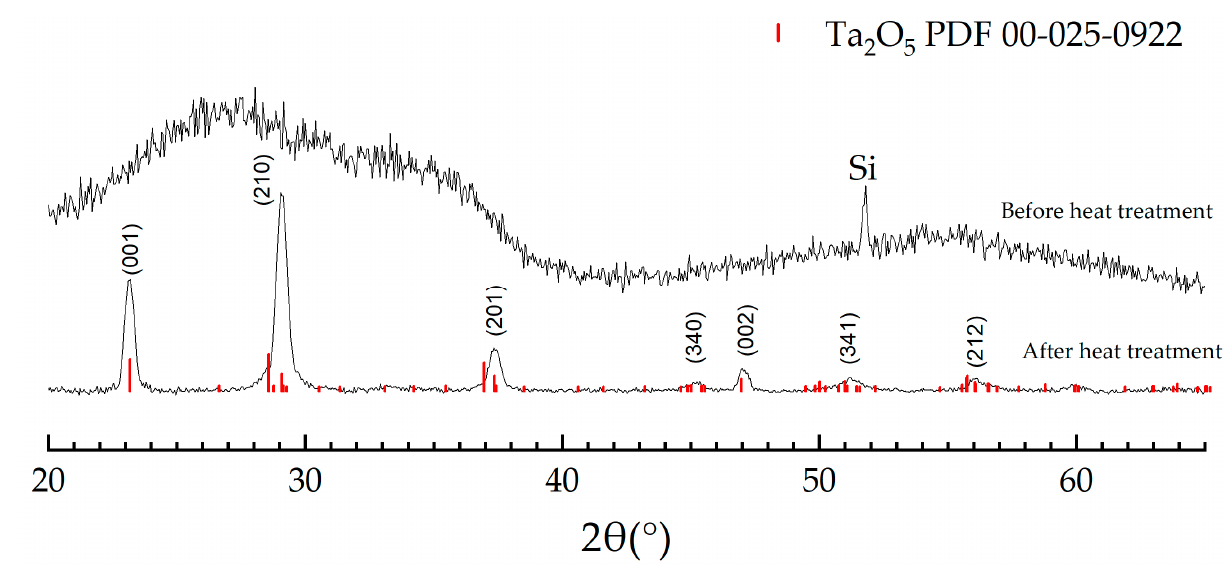
Figure 5. XRD of Ta-O films before and after HT.